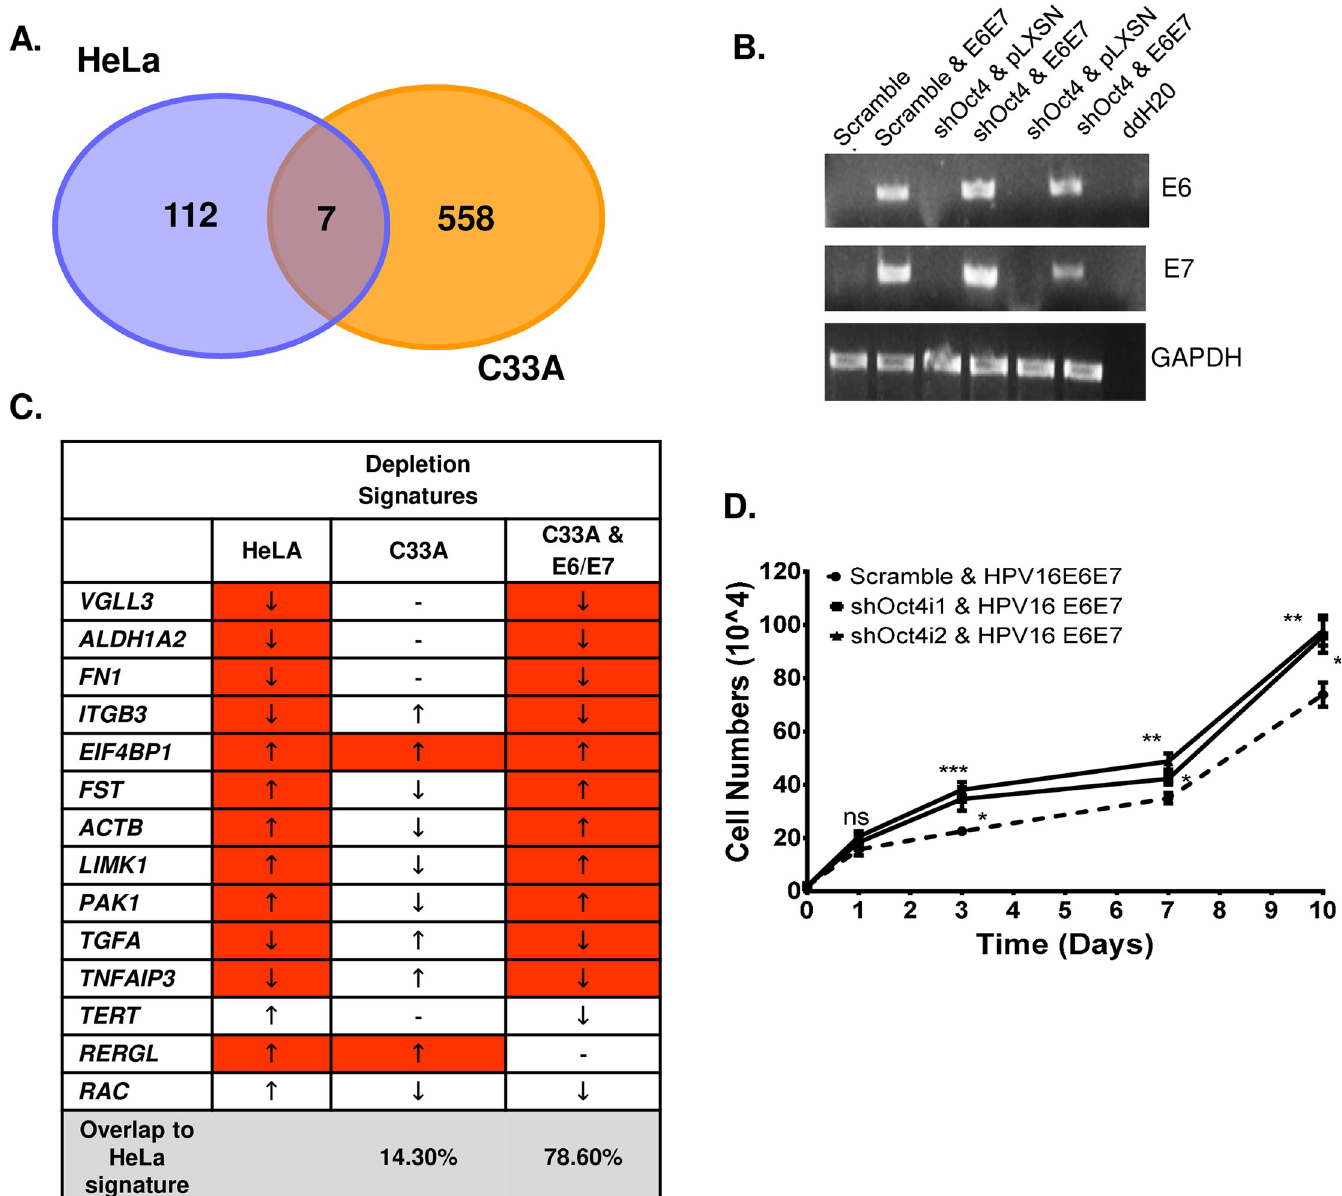
Fig 7. Addition of the viral oncogenes in HPV-negative C33A cells leads to proliferation and transcriptional rescue. RNA-sequencing analysis revealed differentially expressed genes in HPV-positive (HeLa) and–negative (C33A) cells. (A) Amongst the highly deregulated genes, only seven are shared in HeLa and C33A cells. (B) Semi-quantitative PCR shows successful infection of the HPV16 viral oncogenes in stable Oct4-knockdown C33A cells. (C) 78.6% of the genes that were deregulated in Oct4-depleted C33A-E6E7 cells adopt a profile resembling that of HeLa Oct4-depletion signature. A two-sided Unpaired t-test was used to calculate significance (D) Cell numbers of Oct4-knockdown C33A cells upon transduction with the viral oncogenes at 1, 3, 7 and 10 days are illustrated in the form of growth curve. Statistical differences were examined by Mann-Whitney U t-test (two-tailed). All the data plotted are taken from three independent experiments (mean ± SEM), (ns = non-significant, � p < 0.05, �� p < 0.01, ��� p < 0.001, ���� p <